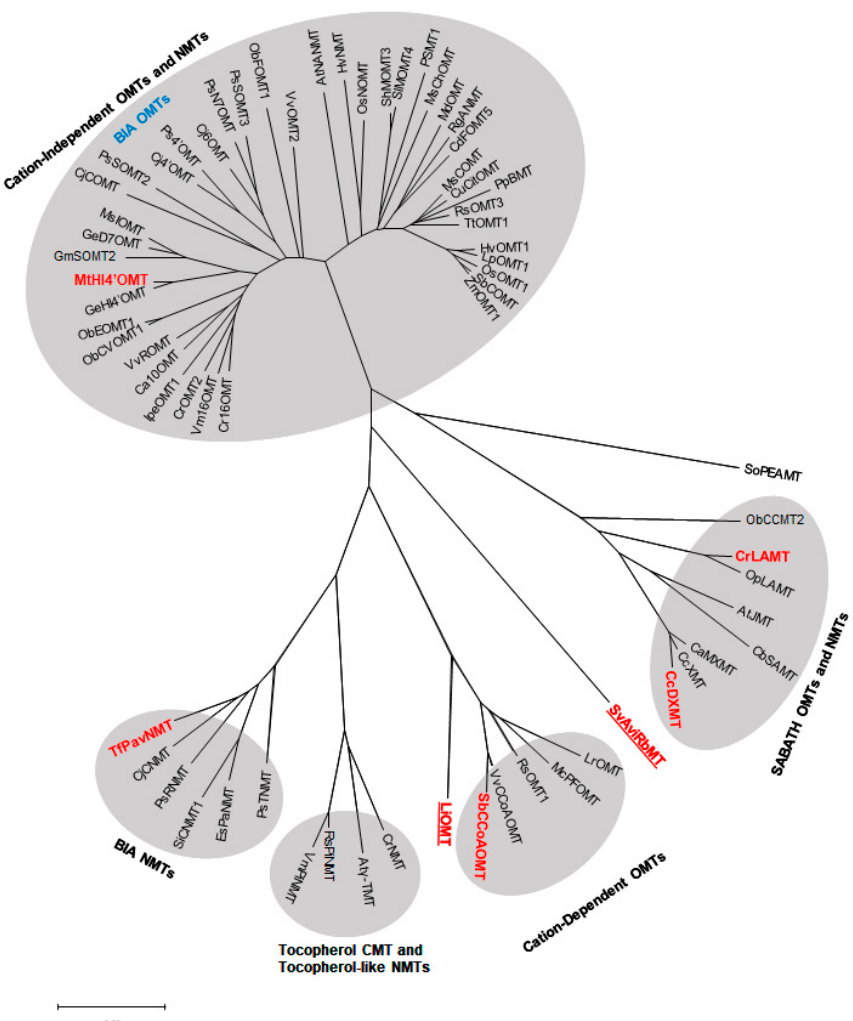
Figure 4. Phylogenetic relationships among functionally characterized plant NPMTs and bacterial MTs. A phylogenetic tree was generated using the neighbor-joining method and the Poisson correlation method via MEGA X [161]. The scale bar shows the amino acids substituted per sequence alignment. Bolded sequences indicate the NPMTs further analyzed in this review. The underlined sequences are bacterial methyltransferases, showing the relationship between bacteria and plant NPMTs. The plant species and accession numbers can be found in Table 1. The bacterial MT species and accession numbers are: LiOMT, Leptospira interrogans O-methyltransferase (WP_000087781); SvAviRbMT, Streptomyces viridochromogenes antibiotic-resistant mediating O-methyltransferase (WP_003998250).